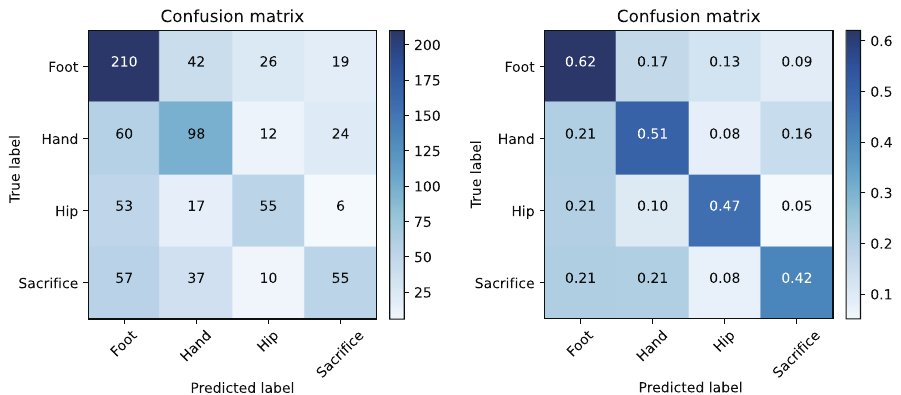
Figure 5. The number of cases (the matrix in the left ) and the F -values (the one in the right ) in confusion matrix when predicting the Kano’s classification for 781 scenes with all datasets (accuracy